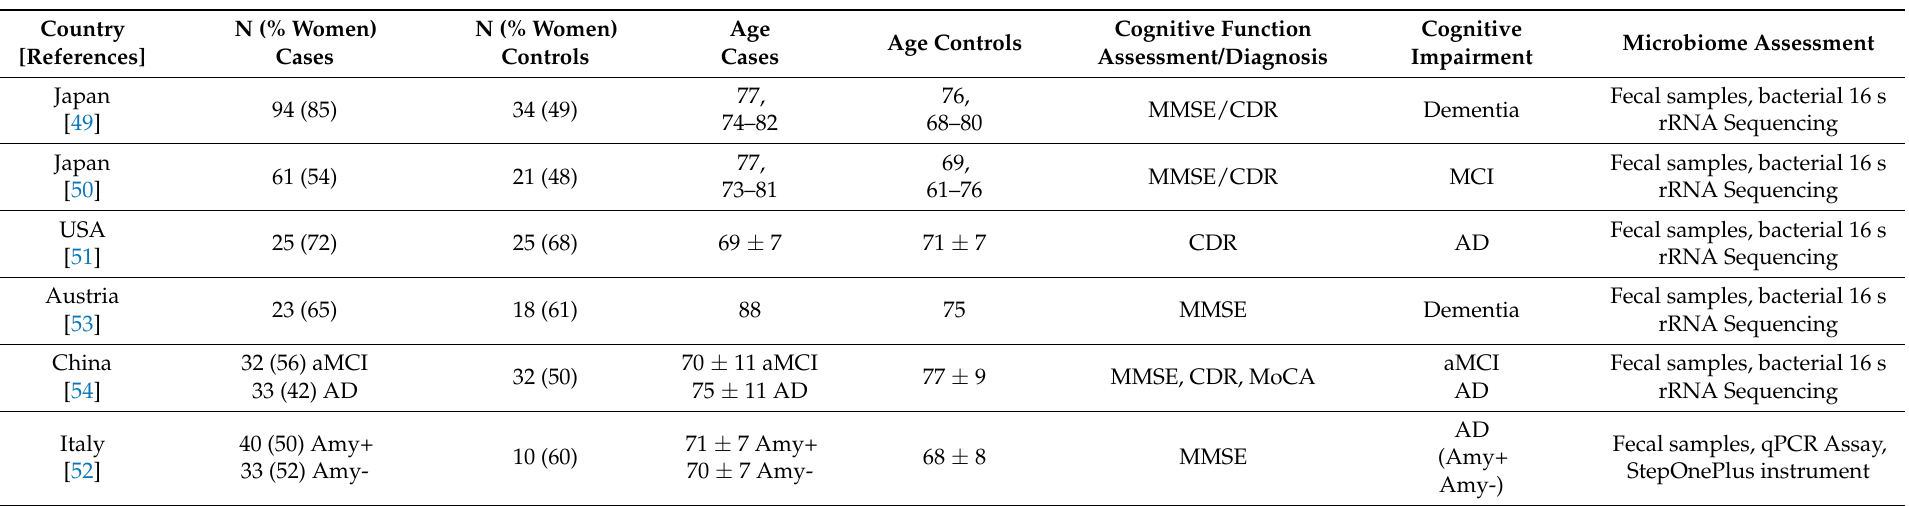
Table 3. Methodological issues of studies about microbiome composition in cognition impairment—case